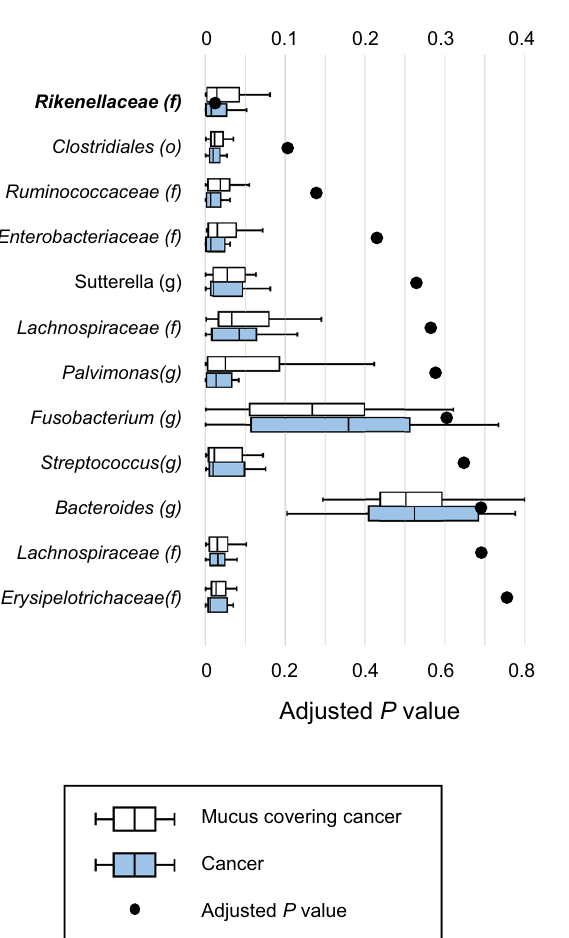
Figure 3. Comparisons of relative abundance in the mucus covering cancer tissue and cancer tissue after washing at up to the genus level by boxplot. Whiskers are extended to the most extreme data point, which is no greater than 1.5 × the interquartile range from the edge of the box in the boxplot. Statistical significance was determined using the Wilcoxon signed-rank test. The Benjamini–Hochberg method for controlling the false- discovery rate was used for multiple